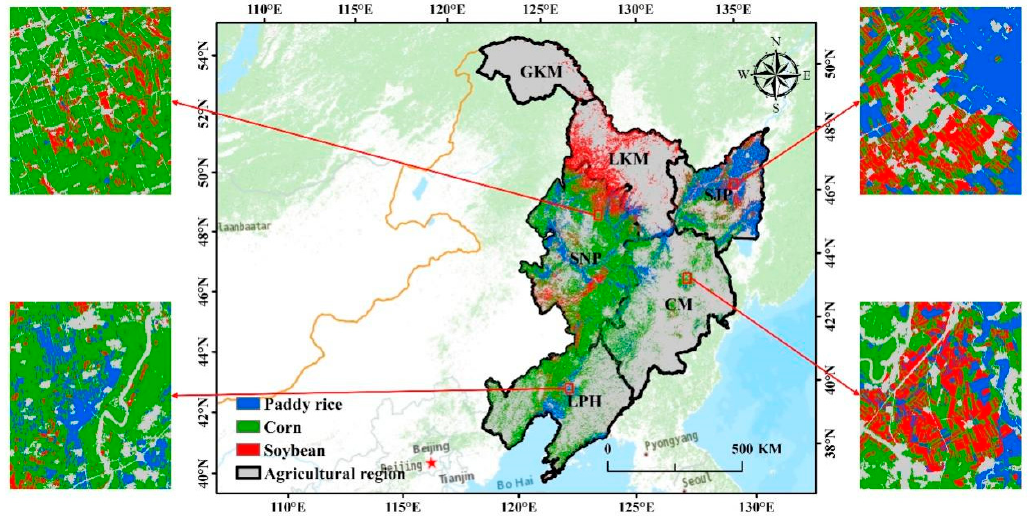
Figure 7. Crop type classi fi cation results in the growing season of 2020.